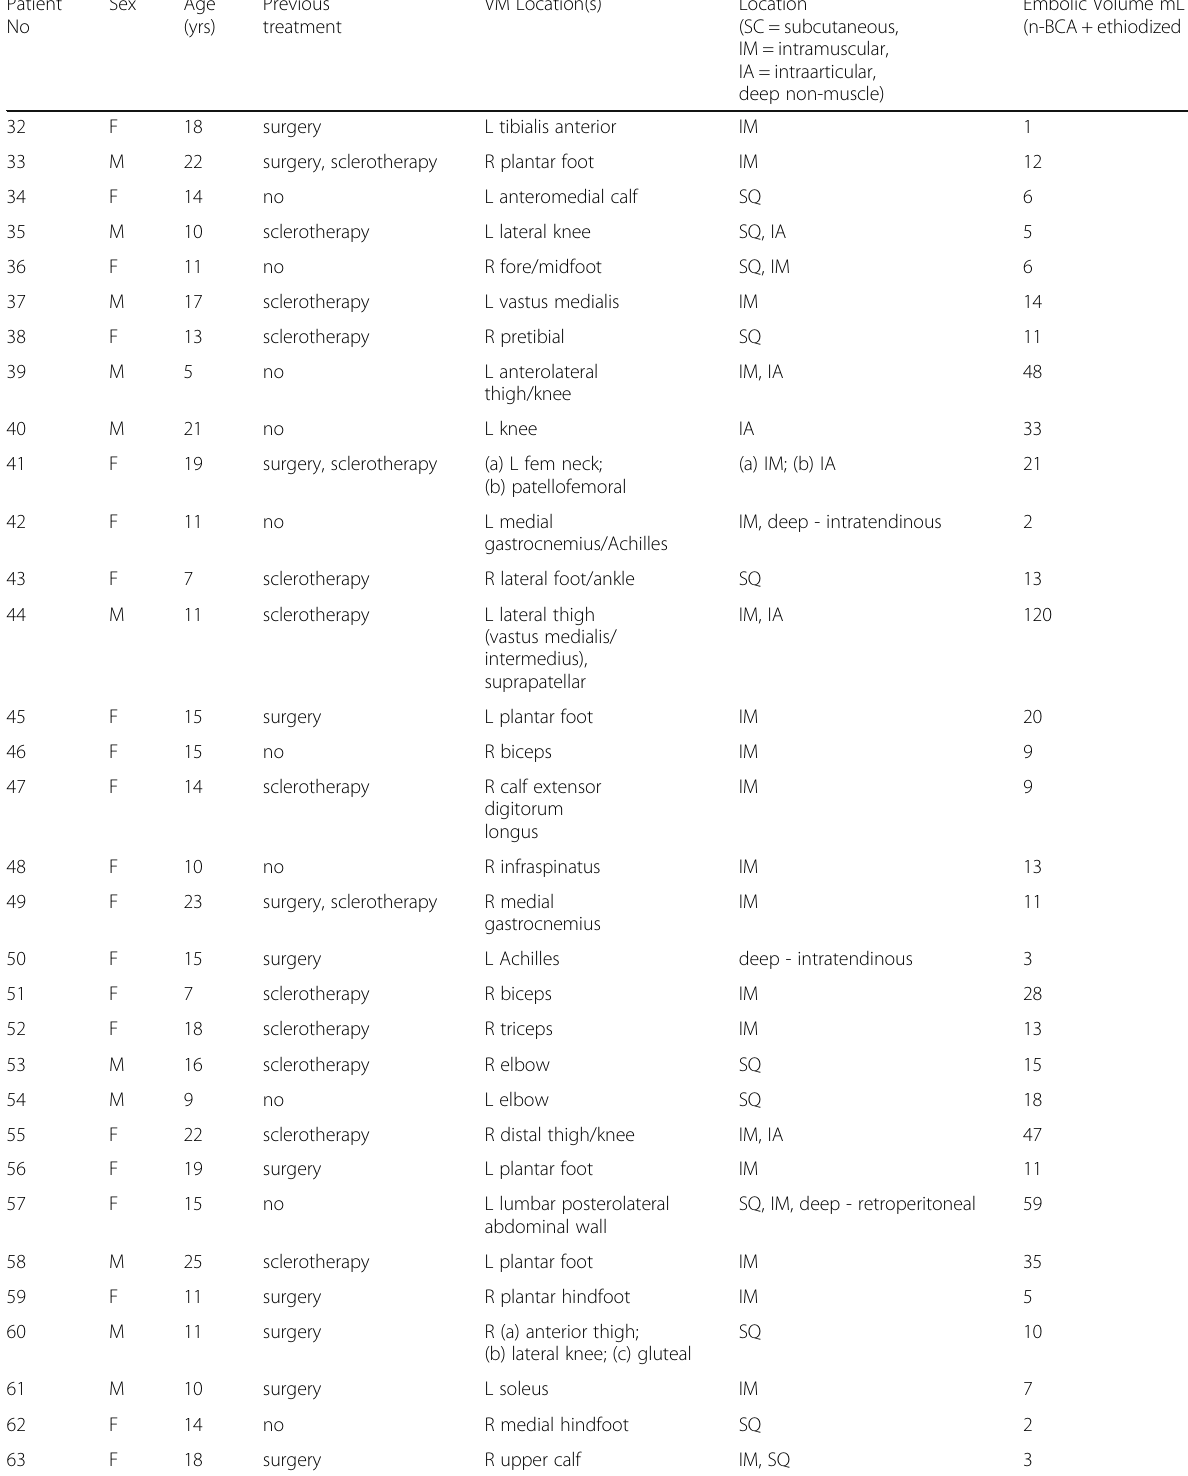
Table 1 Patient demographics, treated lesion characteristics, and embolic material volumes